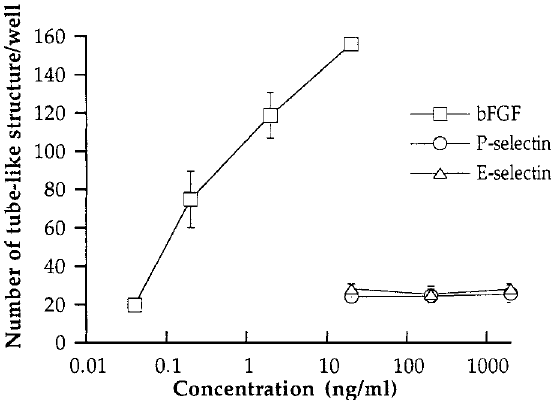
FIG. 2. Effect of bFGF and soluble E- and P-selectins on tube formation in Matrigel by HUVEC cells. The number of tube- like structures in unstimulated cells was 19 ±